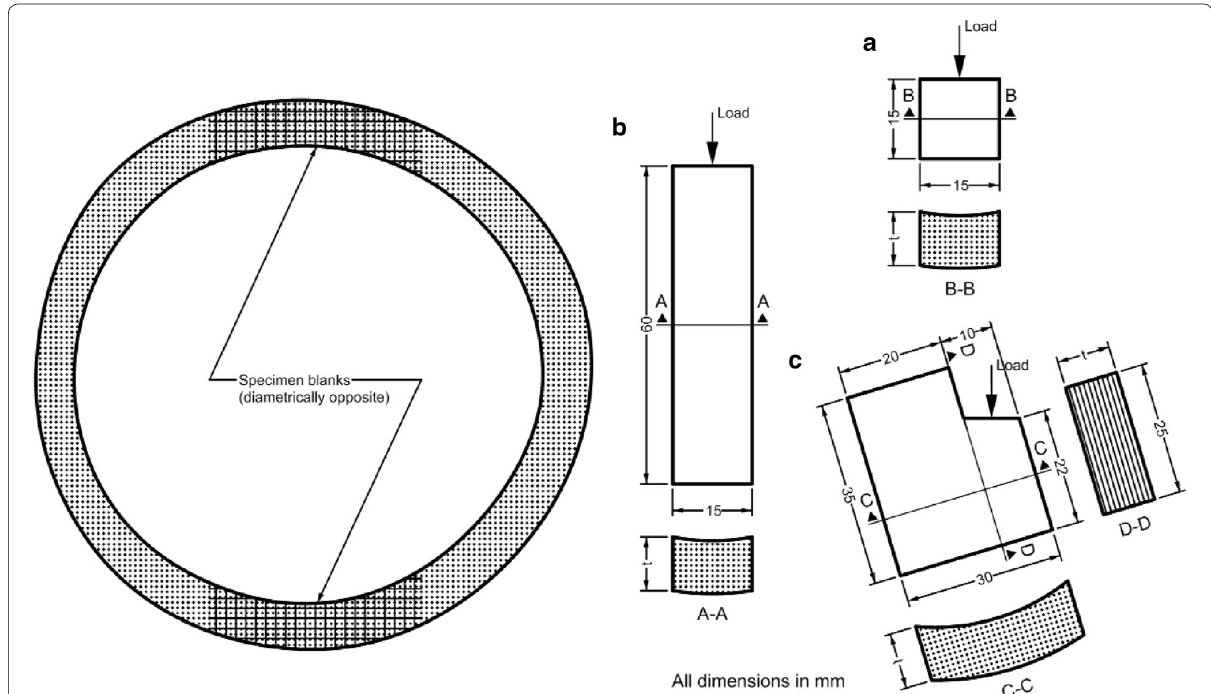
Fig. 1 Specimens on cross-section and a compressive strength, b elastic modulus and c shear strength